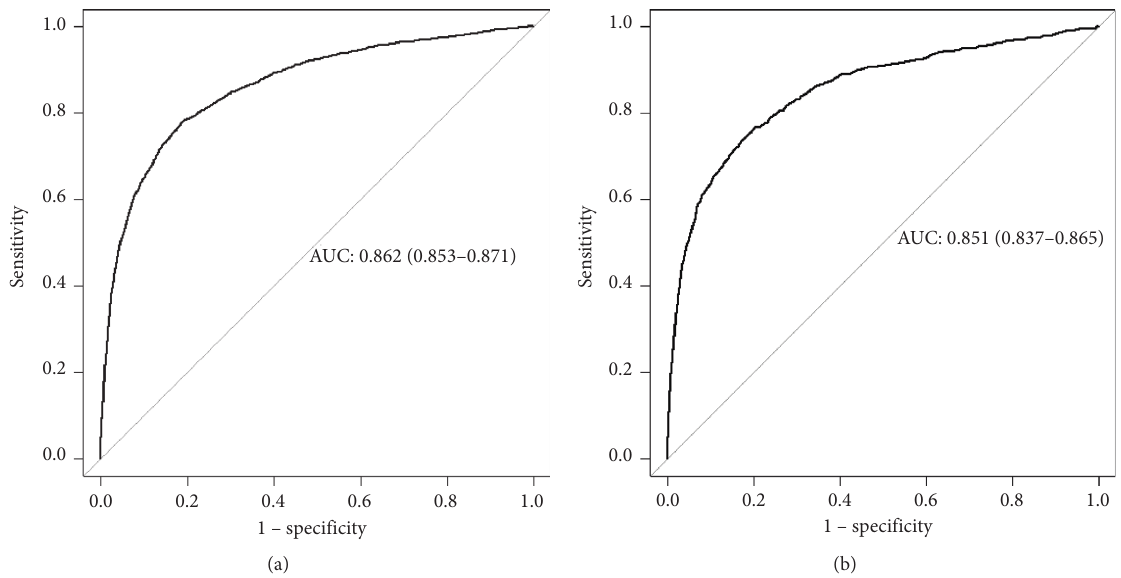
Figure 3: The receiver operating characteristic curve of nomogram. (a) In training set; (b) in validation